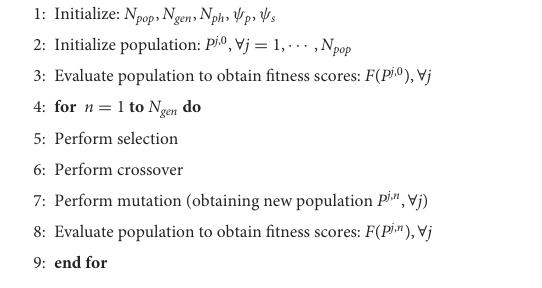
Algorithm 3 Real-coded genetic algorithm for image similarity